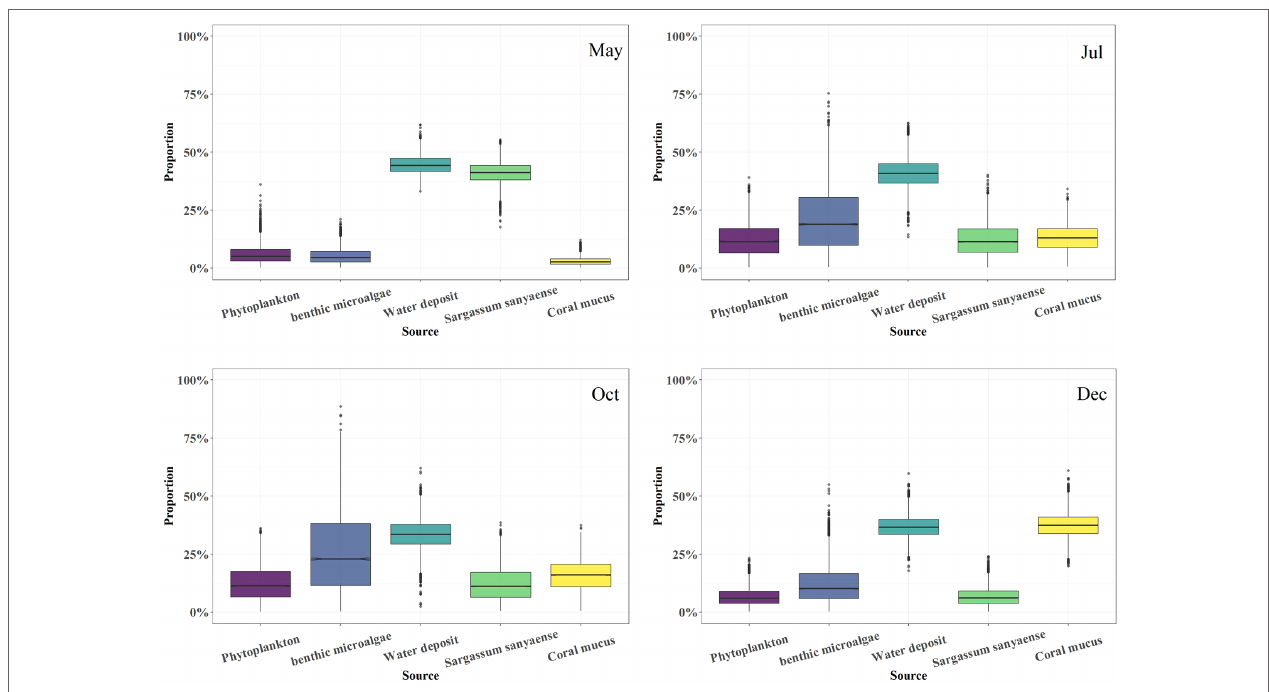
FIGURE 7 | Food composition of the cultured sea cucumber Stichopus monotuberculatus from May to December